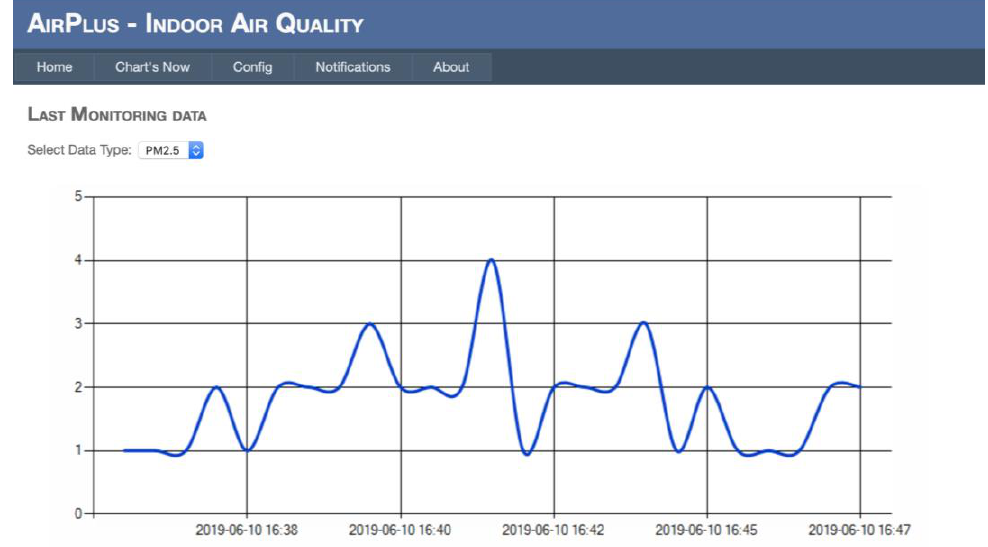
Figure 8. AirPlusWeb : PM monitoring data — chart representation.